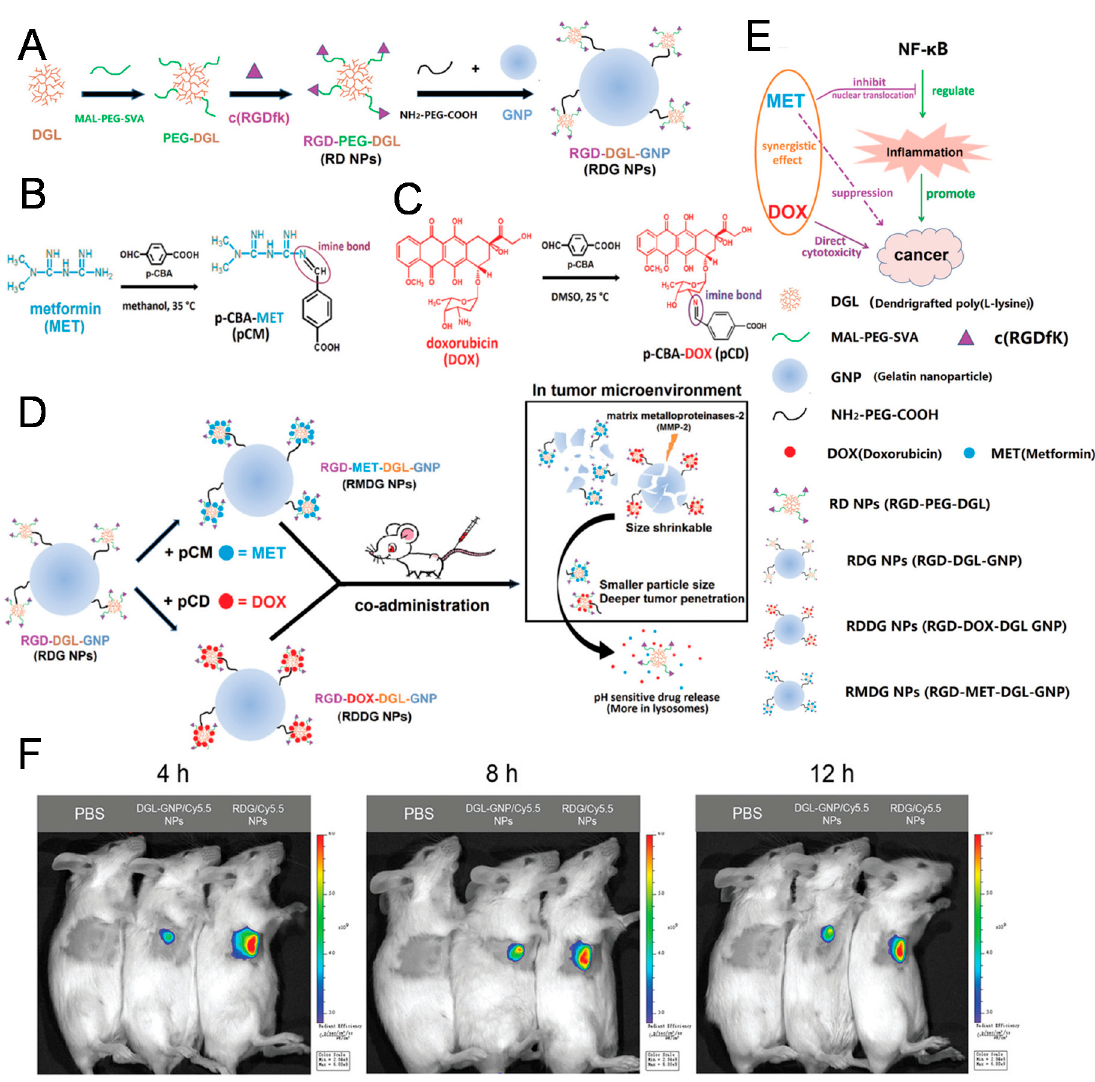
Figure 2. Peptide-conjugated NPs. Schematic illustration of RGD-doxorubicin (DOX)-dendri-grafted poly-L-lysine (DGL)-gelatin nanoparticles (GNP) (RDDG NPs) and RGD-metformin (MET)-DGL-GNP (RMDG NPs). ( A ) Synthetic procedure for RGD-DGL-GNP (RGD NPs). Chemical structure and synthetic procedure for ( B ) 4-Carboxybenzaldehyde (p-CBA)-MET (pCM) and ( C ) p-CBA-DOX (pCD). Illustration of the RDDG NPs and RMDG NPs in the tumor microenvironment ( D ) and their antitumor/anti-inflammatory effects ( E ). ( F ) In vivo fluorescence images showing tumor accumulation of NPs with or without RGD ligand. Reproduced with permission from ref. 29.